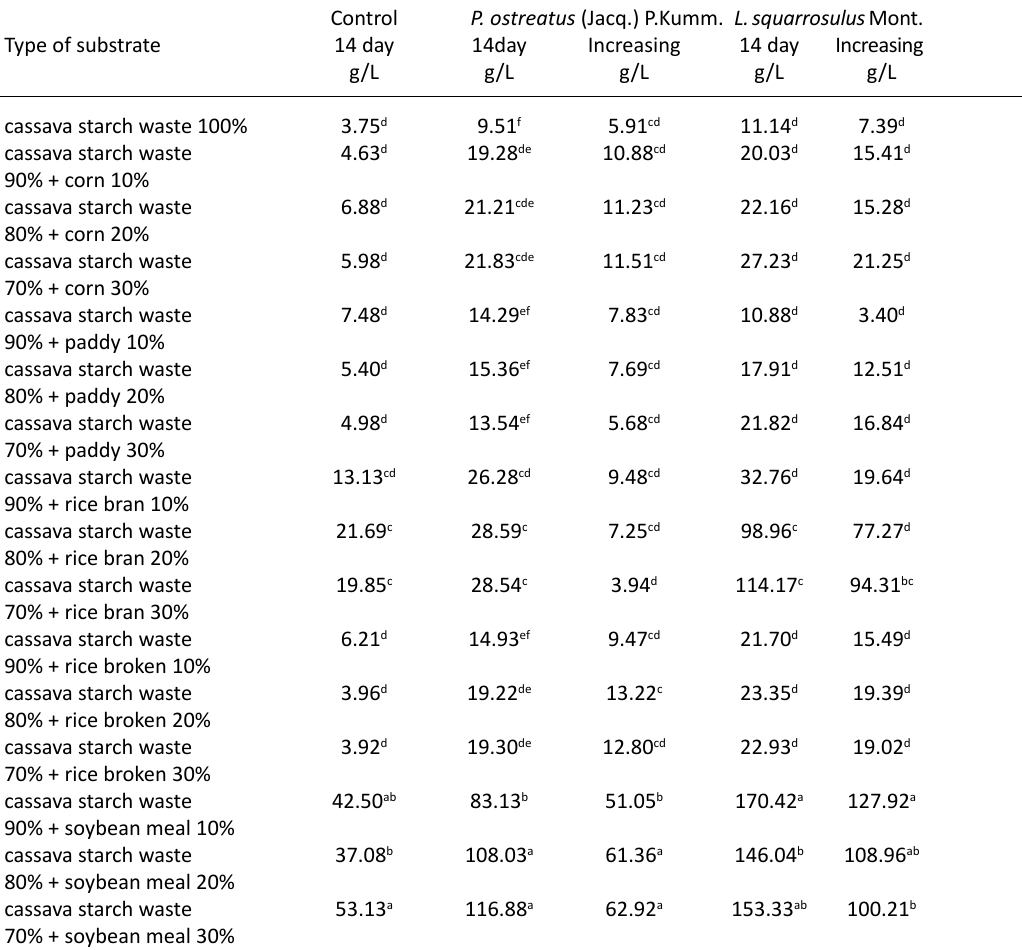
Table 5. Effect of P. ostreatus (Jacq.) P.Kumm. and L. squarrosulus Mont. on protein content at 14 day (g/L)